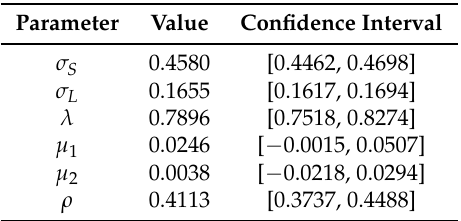
Table 2. Parameter estimates and 95% confidence intervals for the Seasonal Gabillon model (14), using 1997–2007 futures curves